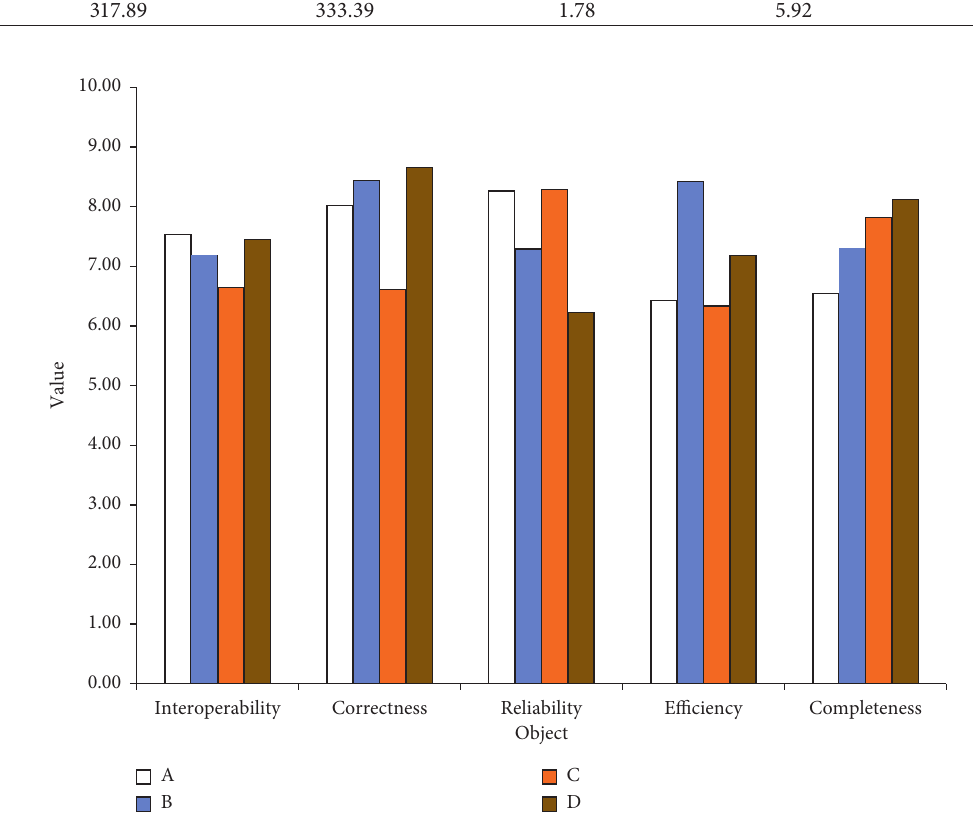
Figure 5: The performance of the four